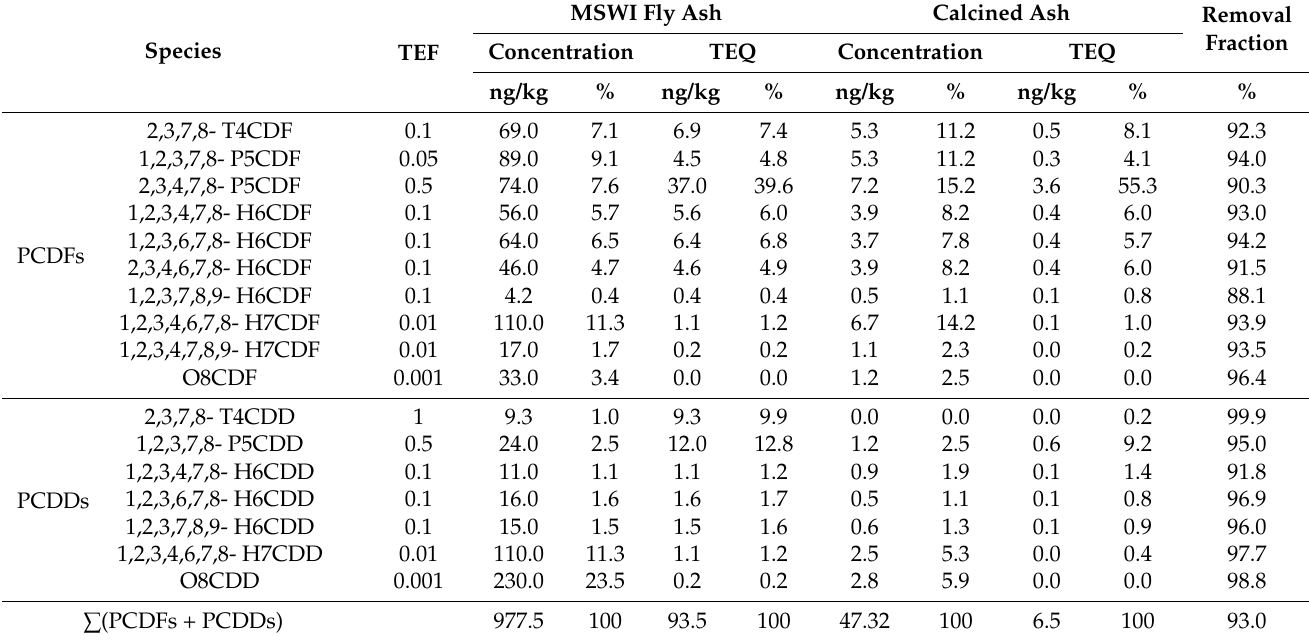
Table 4. Dioxins distribution in MSWI fly ash and calcined